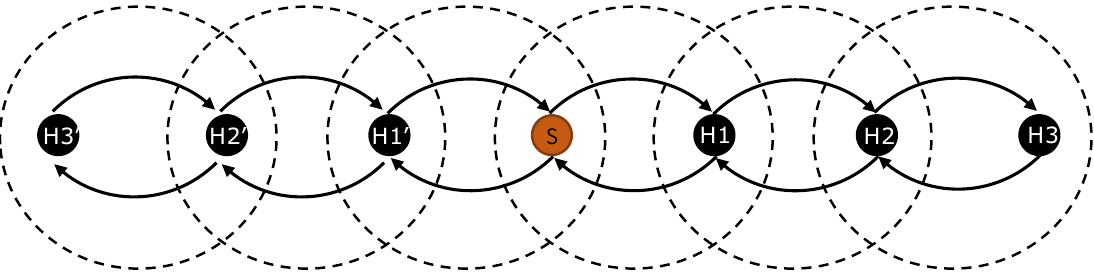
Figure 6. Multi-hop network topology abstraction.